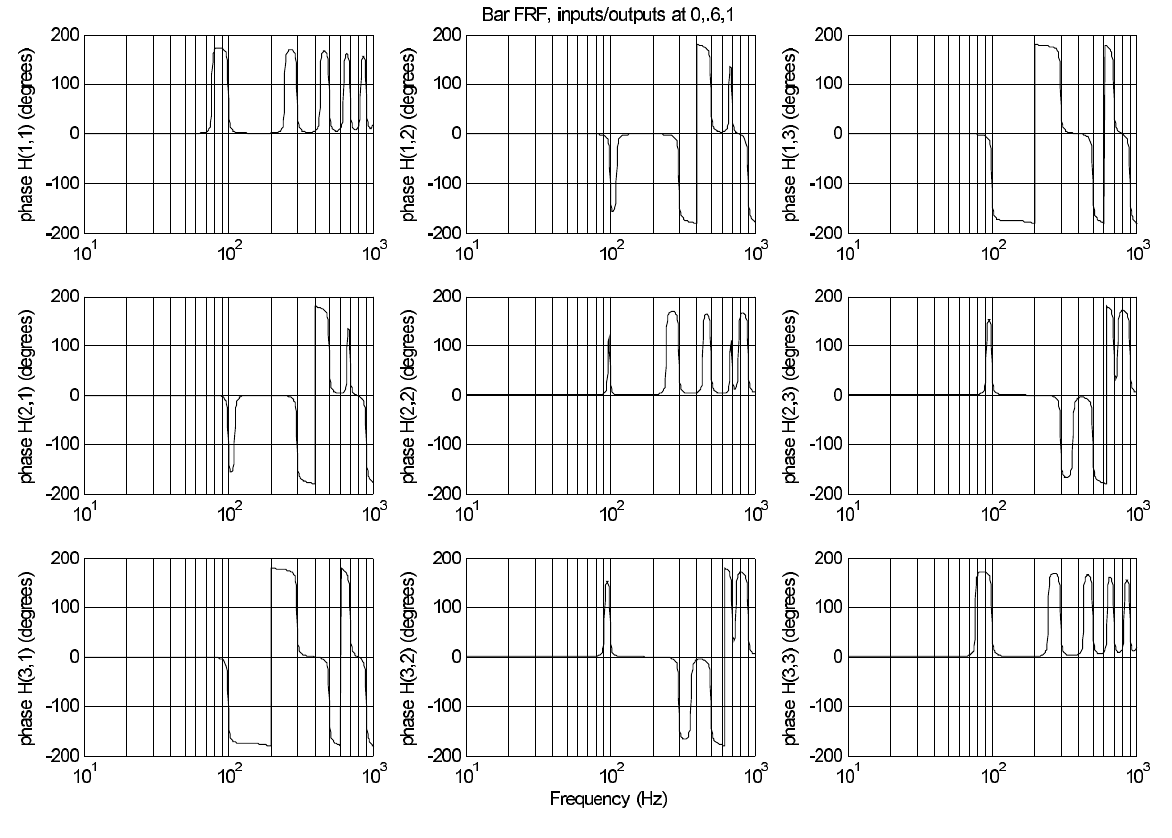
Fig. 5. FRF’s, 1000 lb bar, phase